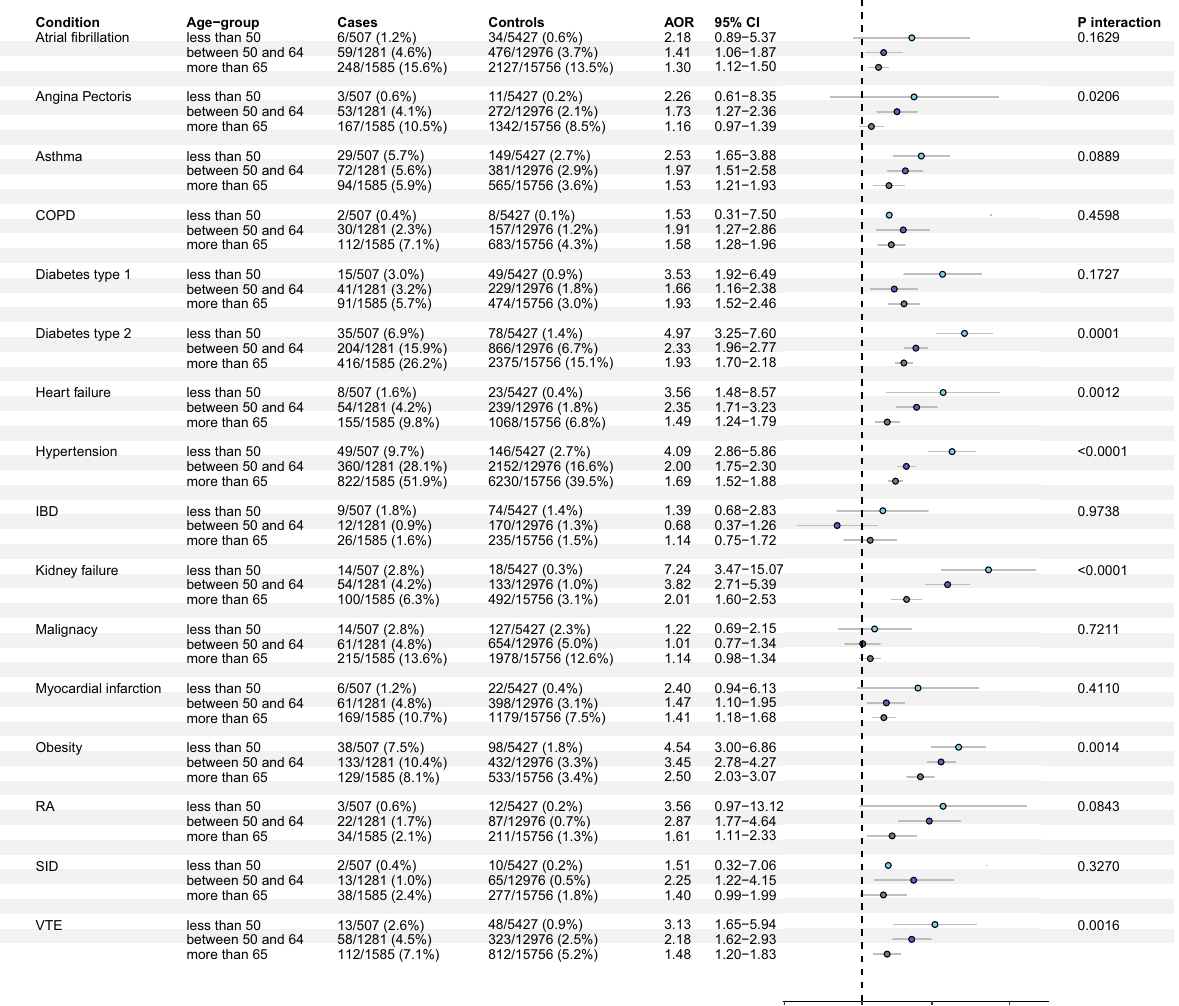
figure on next Fig. 4 a . Co-morbidites and severe COVID-19. Comparison of effect sizes between young (< 50 years) and old individuals (> 65 years). As shown, effect sizes for the co-morbidites are generally larger in the younger population. Co-morbidities without evidence of association (p > 0.05) in any group are not shown. [Adjusted ORs, 95% CIs, p-values for significant age interactions are indicated by the circle size for each condition. b : Co-morbidites and severe COVID-19. Comparison of effect sizes between women and men in the young age group (< 50 years). Hypertension and type 2 diabetes display significantly larger effect sizes in women compared to men. Co-morbidities without evidence of association ( p > 0.05) in any group are not shown. [Adjusted ORs, 95% CIs, and p-values for significant sex interactions are indicated by the circle size for each